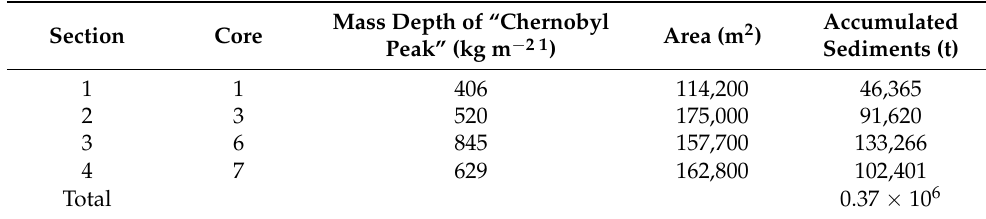
Table 5. Mass depth of “Chernobyl Peak” and areas and masses of sediments in selected sections of the flooded channel of Schekino Reservoir for the post-Chernobyl period.